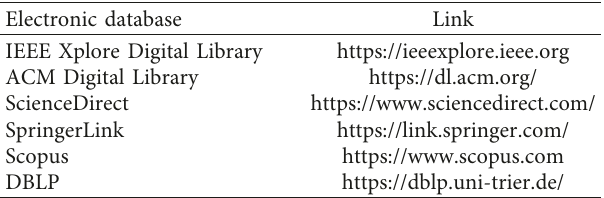
Table 1: Electronic database.